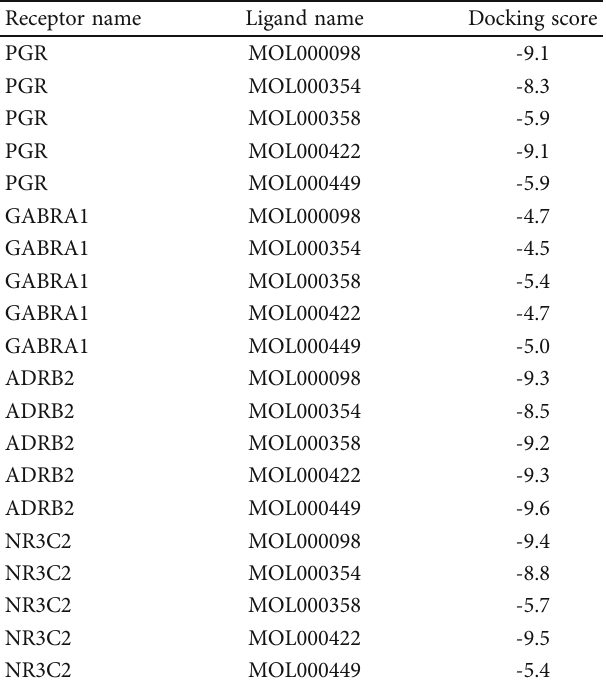
Table 2: Docking score of active chemicals to key